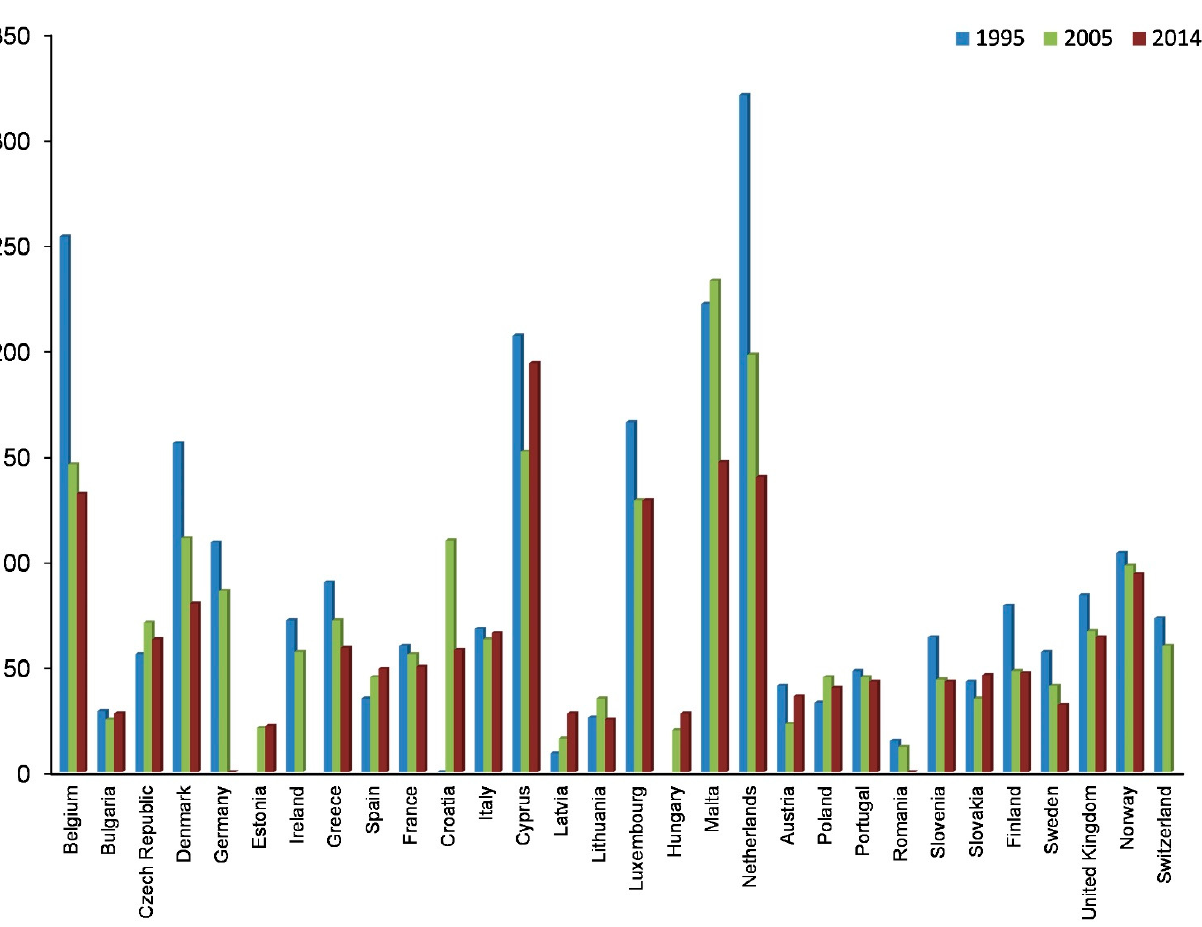
Figure 1. Annual gross N balance (kg N ha − 1 of agricultural land) in selected EU countries (own study based on Eurostat data [15].